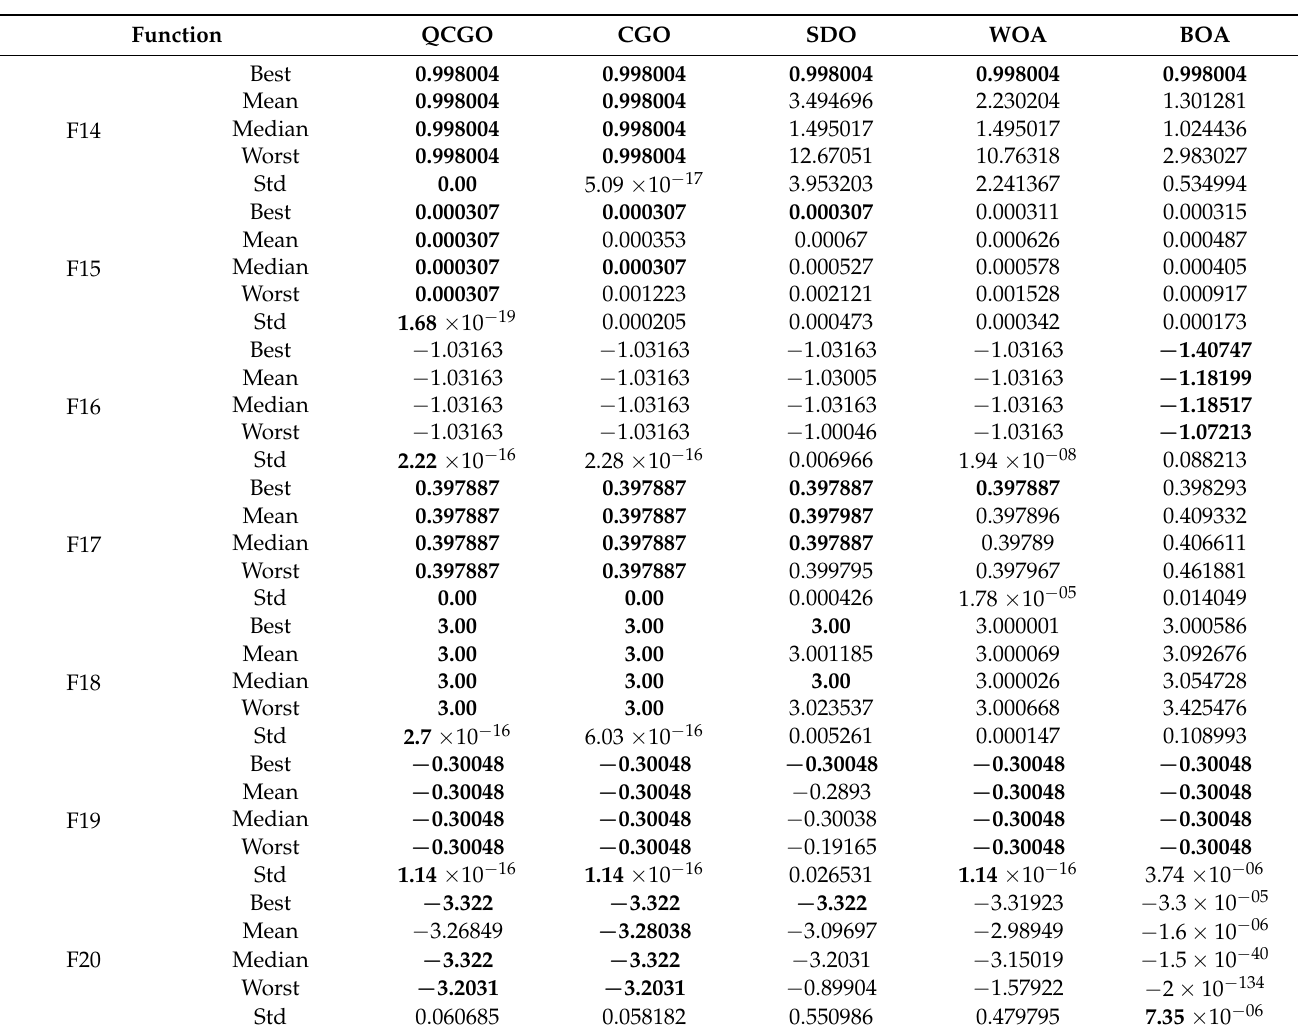
Table 6. Results of composite benchmark